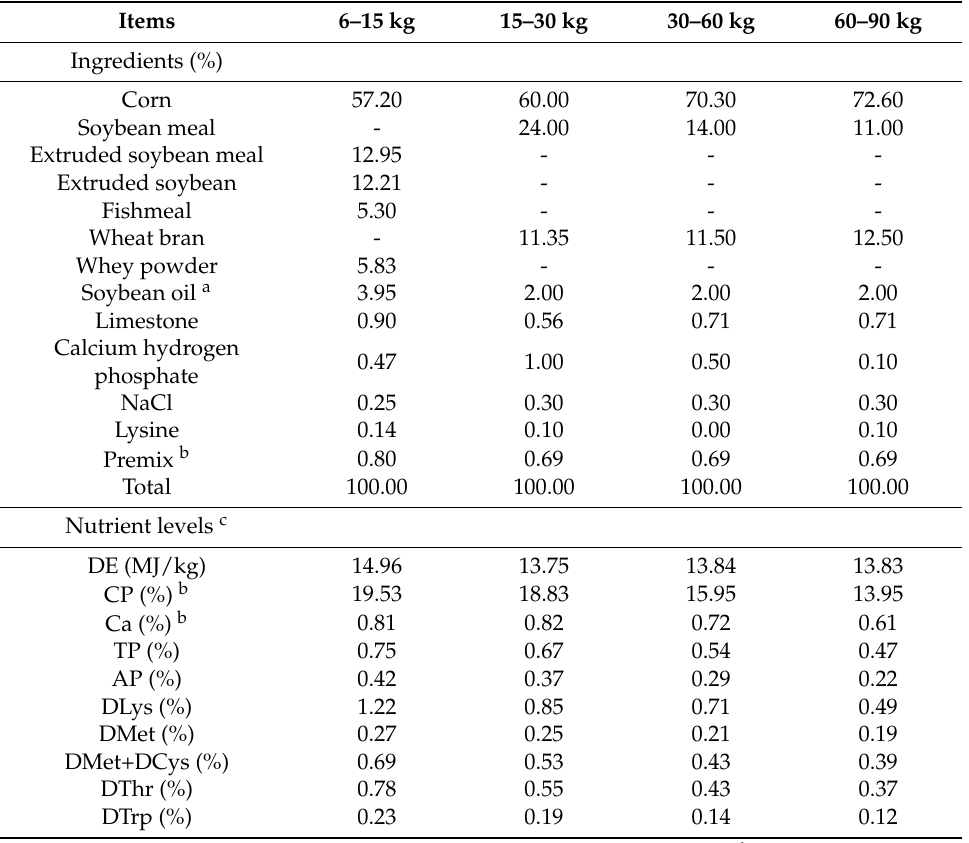
Table 1. Composition of the basal diets for growing pigs at different periods (air-dry basis, %). Items Ingredients (%) Corn Soybean meal Extruded soybean meal